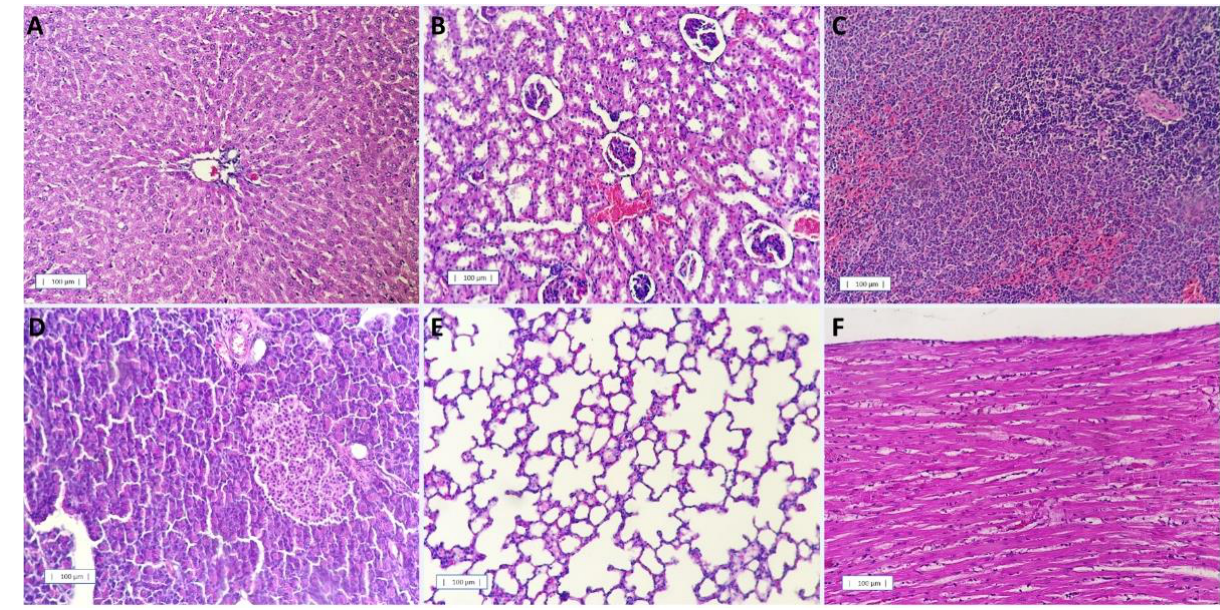
Figure 10. Histopathological evaluation. Representative photomicrographs of ( A ) liver, ( B ) kidney, ( C ) spleen, ( D ) pancreas, ( E ) lung, and ( F ) hearts of animals pre-treated with free oil (100 and 400 mg/kg/p.o.), nanoencapsulated pequi oil (PeNE 100 and 400 mg/kg/p.o.), or the blank for 15 days. The organs of all groups showed standard morphology. Scale bar 100 µ